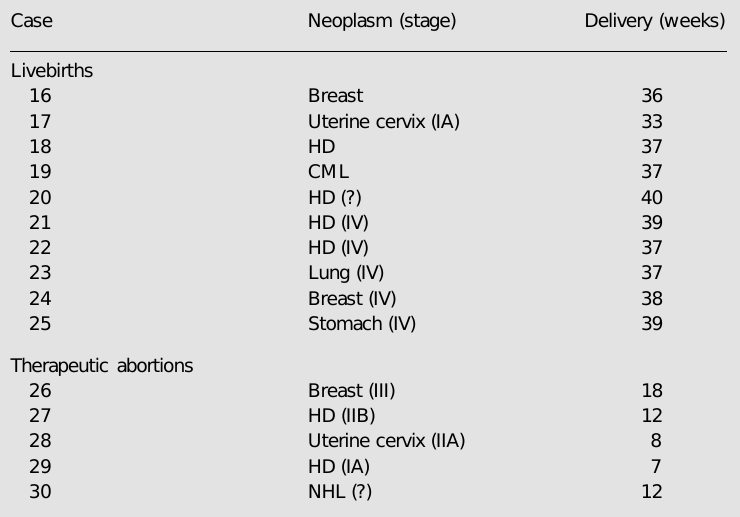
Table 5. Non-exposed pregnancies: